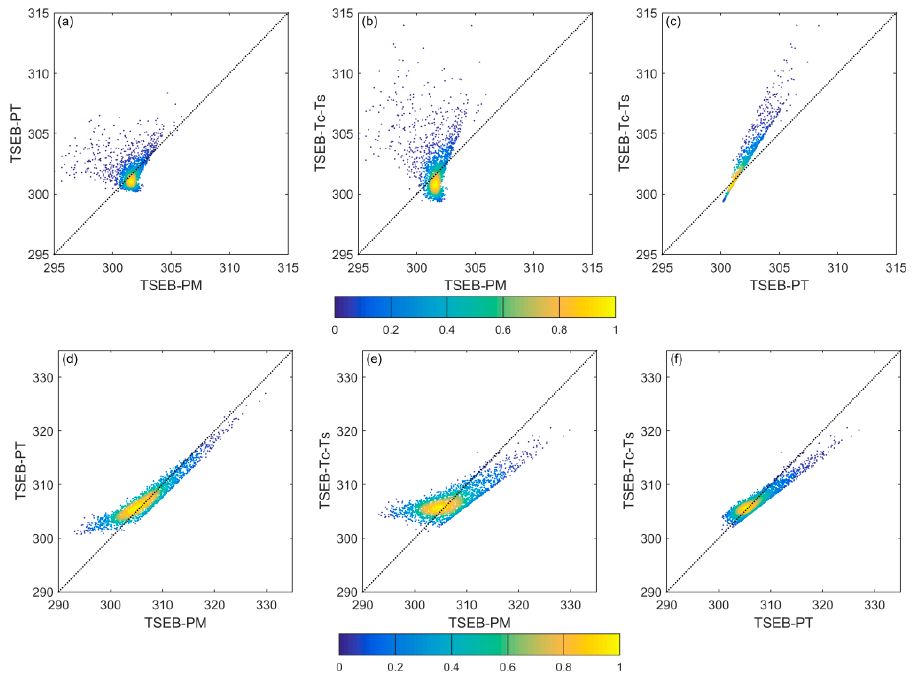
Figure 9. Intercomparison of T c (first row) and T s (second row) derived from TSEB-PT, TSEB-PM, and TSEB- T c- T s in the kernel experimental area on 10 July 2012. The intercompared T c pairs are ( a ) TSEB-PM vs. TSEB-PT; ( b ) TSEB-PM vs. TSEB- T C - T S ; ( c ) TSEB-PT vs. TSEB- T C - T S . The intercompared T s pairs are ( d ) TSEB-PM vs. TSEB-PT; ( e )TSEB-PM vs. TSEB- T C - T S ; ( f ) TSEB-PT vs. TSEB- T C - T S .